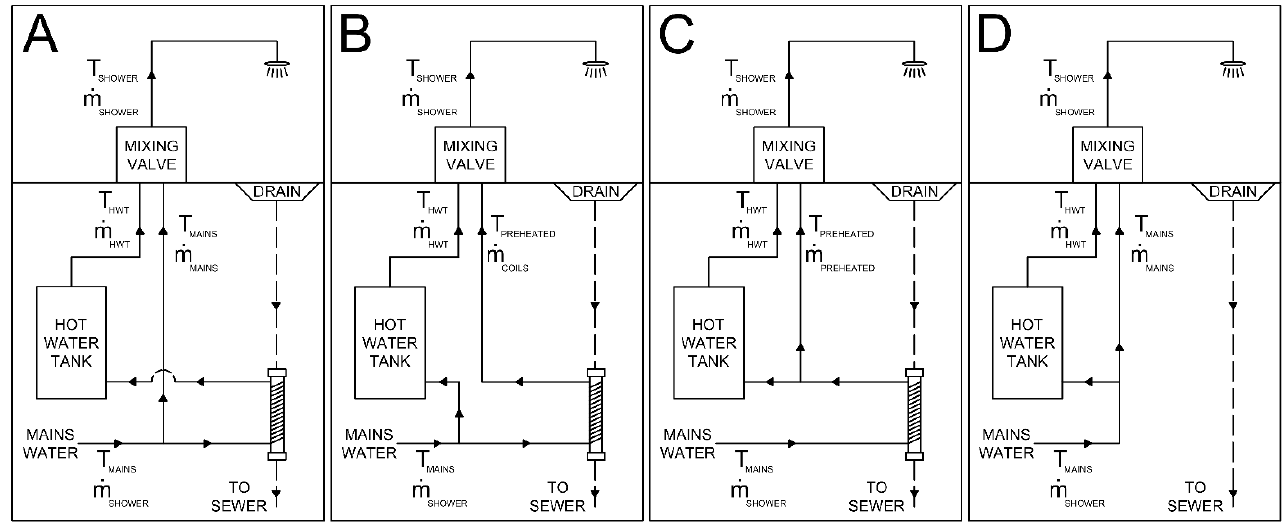
Figure 2. Possible plumbing configurations for DWHR systems in a residential building: ( A ) depicts a system where all preheated water from the DWHR heat exchanger is fed to the water heater; ( B ) depicts a system where all preheated water is fed to the mixing valve at the showerhead; ( C ) is a combination of ( A ) and ( B ); and ( D ) shows the same plumbing system without a DWHR heat exchanger installed.